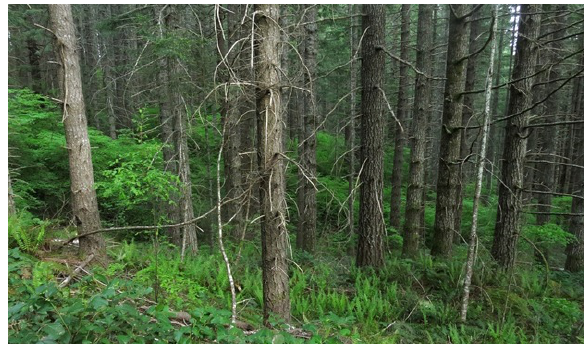
Figure 6: Sample ground-level photograph of target